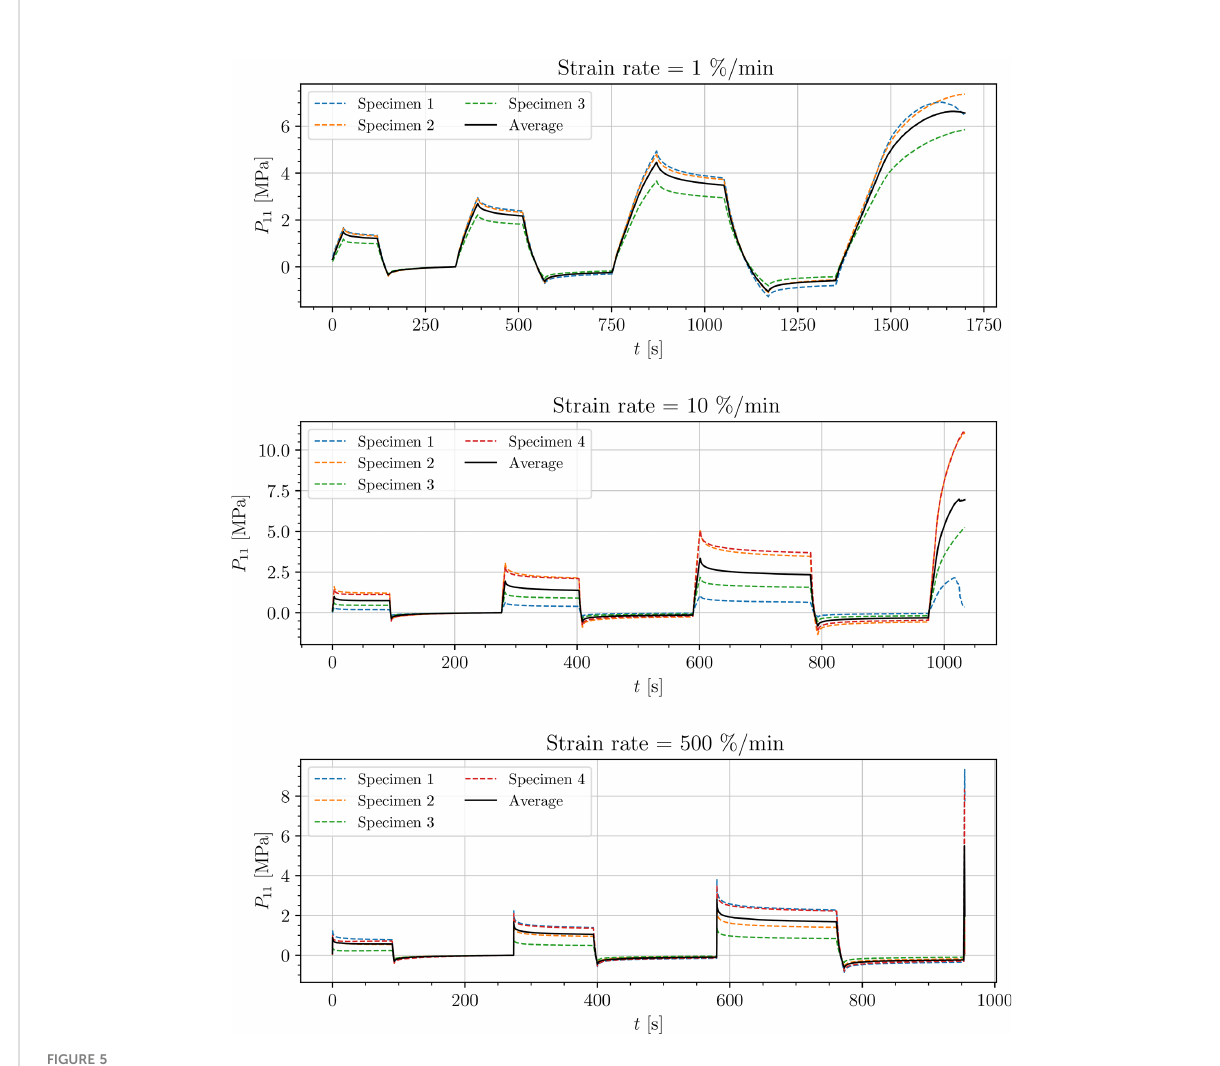
FIGURE 5 Uniaxial cyclic tensile stress-relaxation test of